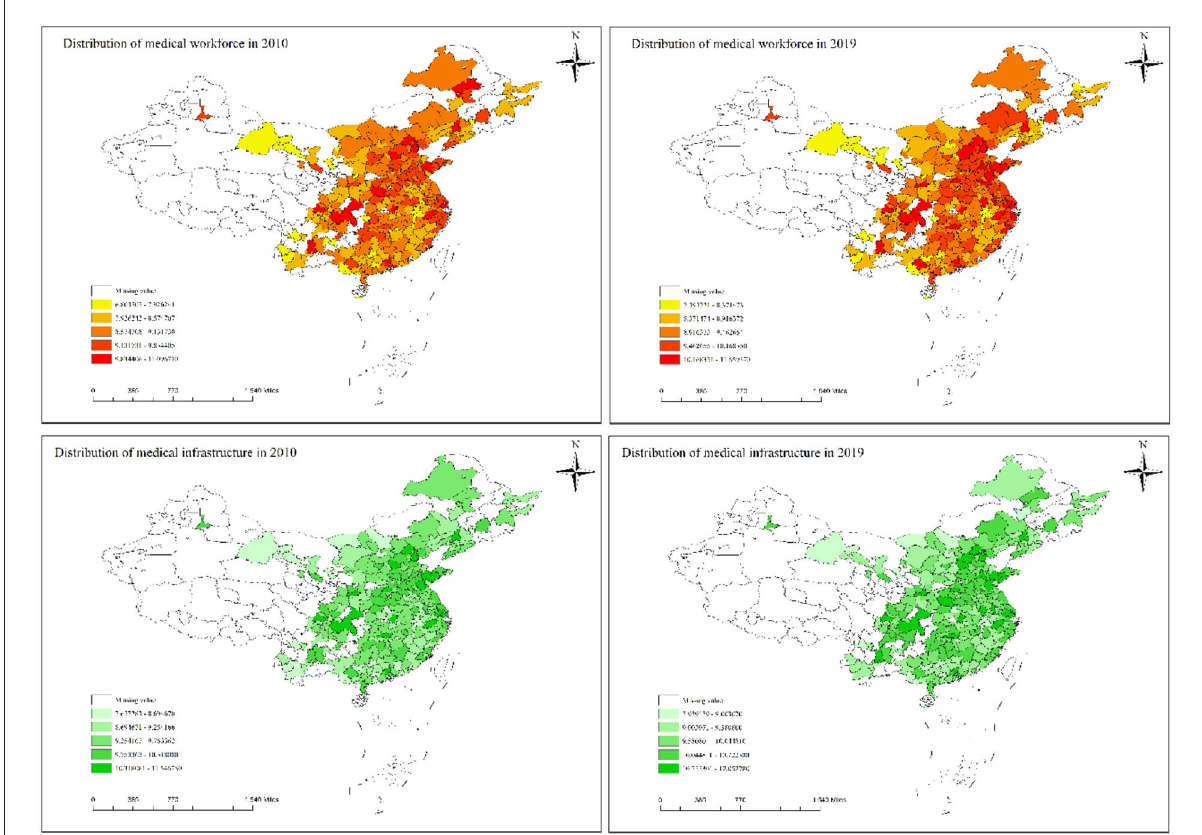
FIGURE2 The spatial distribution of health care environment. The plots in the first row denote the spatial distribution of medical workforce (ln mw ) in 2010 and 2019. The plots in the second row denote the spatial distribution of medical infrastructure (ln mi ) in 2010 and 2019.